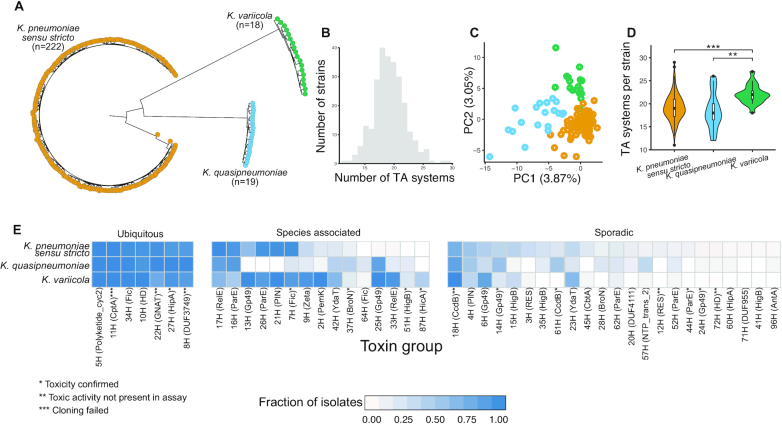
Diversity of toxins in Klebsiella pneumoniae species complex. (A) Core gene phylogeny of the 259 selected K. pneumoniae species complex genomes. (B) Number of predicted TA systems per isolate. (C) First two principal components of PCA analysis of toxin repertoire coloured by K. pneumoniae complex species (yellow: K. pneumoniae sensu stricto, blue: Klebsiella quasipneumoniae, green: Klebsiella variicola). (D) Number of predicted TA systems per isolate, stratified by K. pneumoniae complex species. Pairwise Wilcoxon rank sum test, *P < 0.01, **P < 0.001, FDR corrected. (E) Fraction of isolates from each K. pneumoniae complex species possessing each of the toxin groups. Toxin groups are categorised by their distribution patterns (detailed in Supplementary Table S5). The toxin Pfam profile used to identify the toxin group is in brackets.